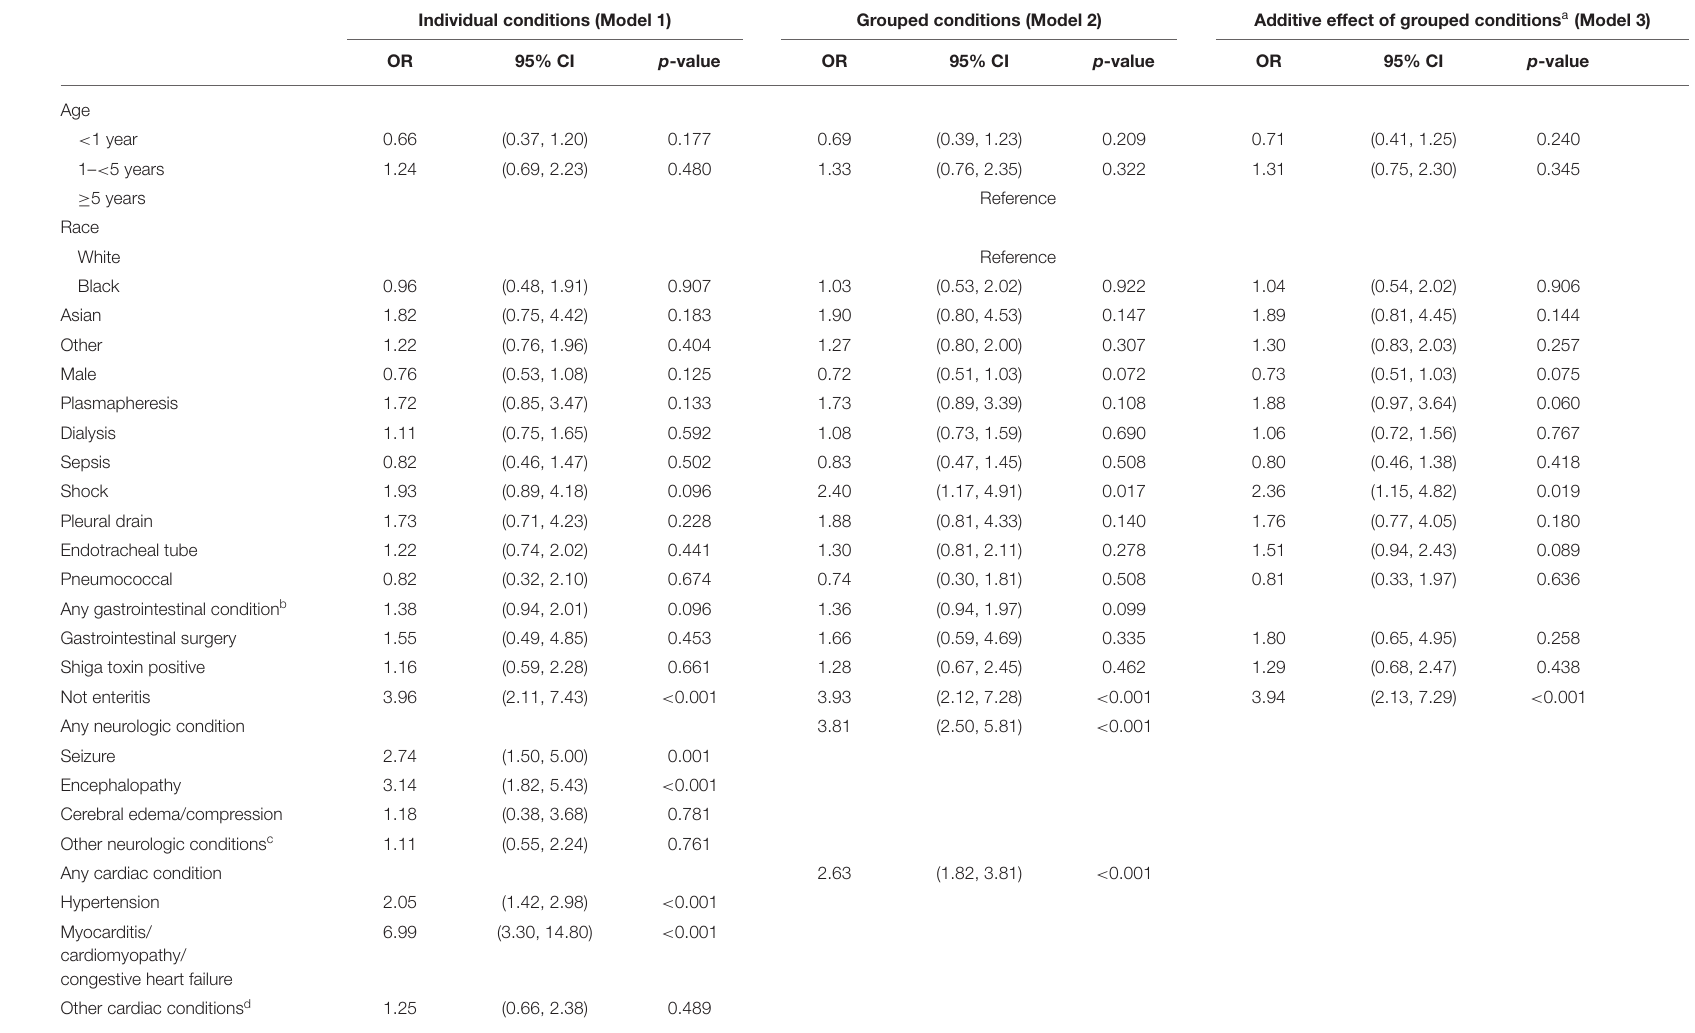
TABLE 3 | Clinical factors associated with eculizumab administration. Individual conditions (Model 1) Grouped conditions (Model 2) Additive effect of grouped conditions a (Model